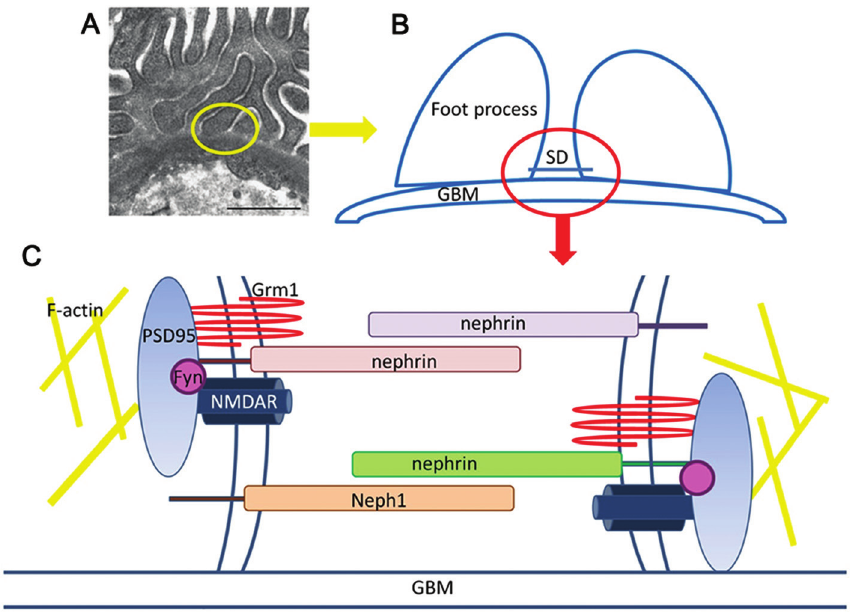
Figure 2 Schematic overview of the slit diaphragm. (A) Transmission electron micrograph of podocyte foot processes. Scale bar, 1 μ m. (B) Schematic illustration of podocyte processes, lying on the glomerular basement membrane (GBM) and laterally connected by the slit diaphragm (SD). (C) According to our data (48), nephrin behaves in podocytes as a synaptic adhesion molecule that clusters glutamate receptors and connect them through scaffolding molecules, such as PSD95, to the actin cytoskeleton of the foot